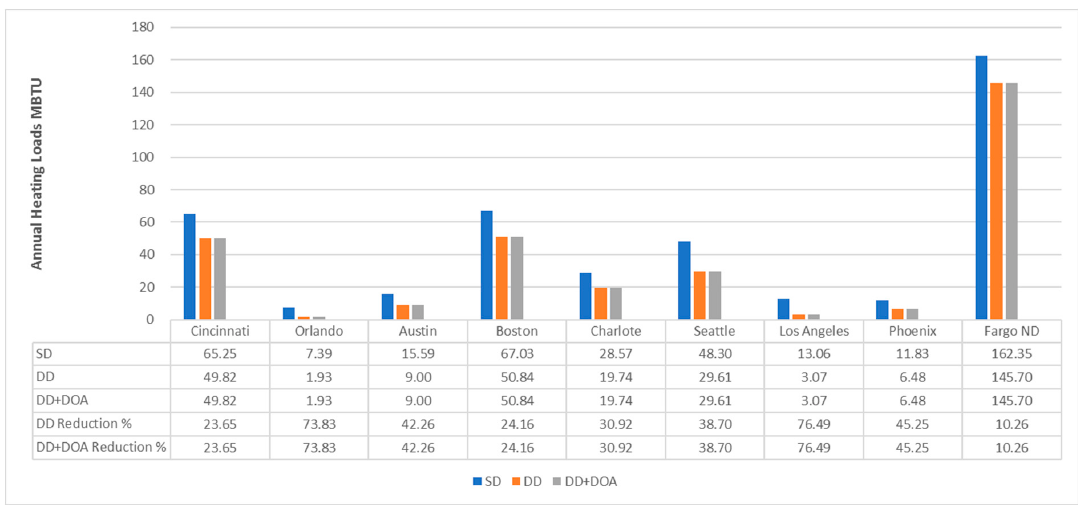
Figure 7. Annual heating loads for three cases and reduction by using the proposed system.